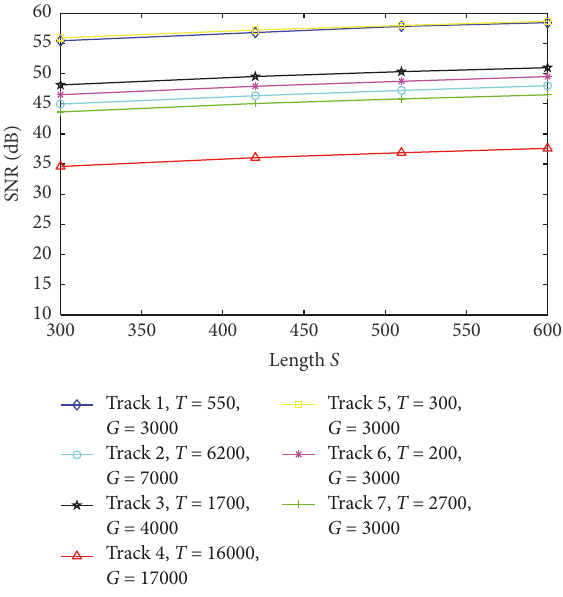
Figure 8: Relationship between SNR and the frame length 𝑆